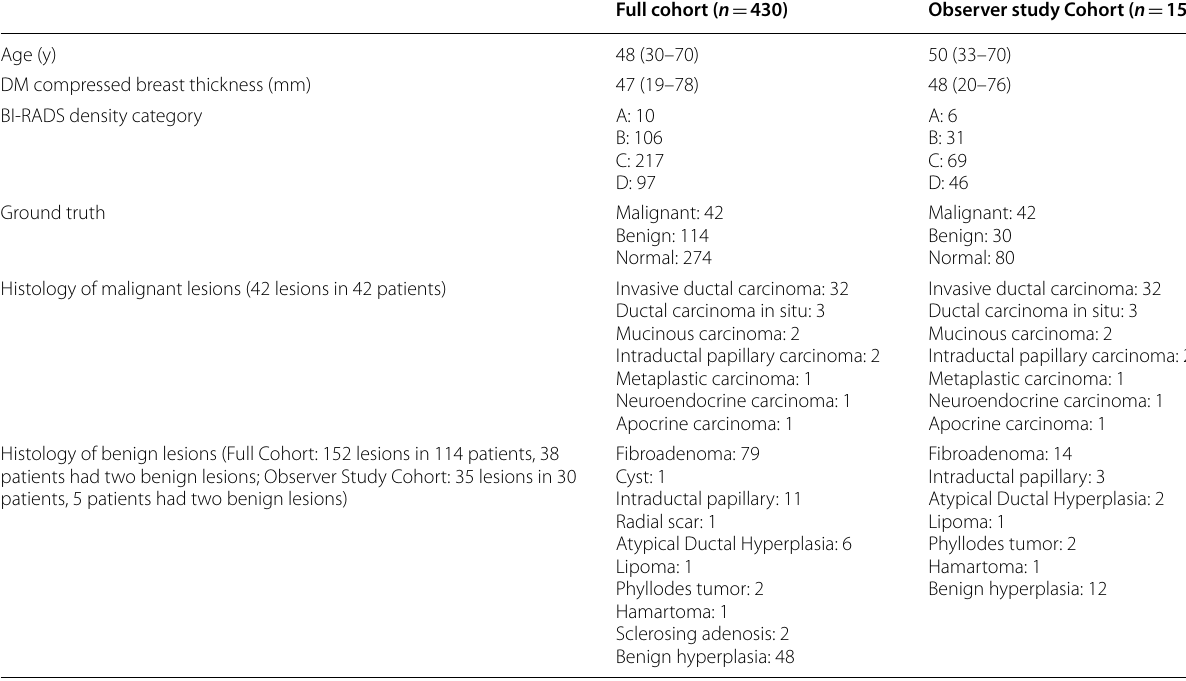
When available, median and range (within parentheses) are given BI-RADS Breast imaging reporting and data system, DM Digital mammography